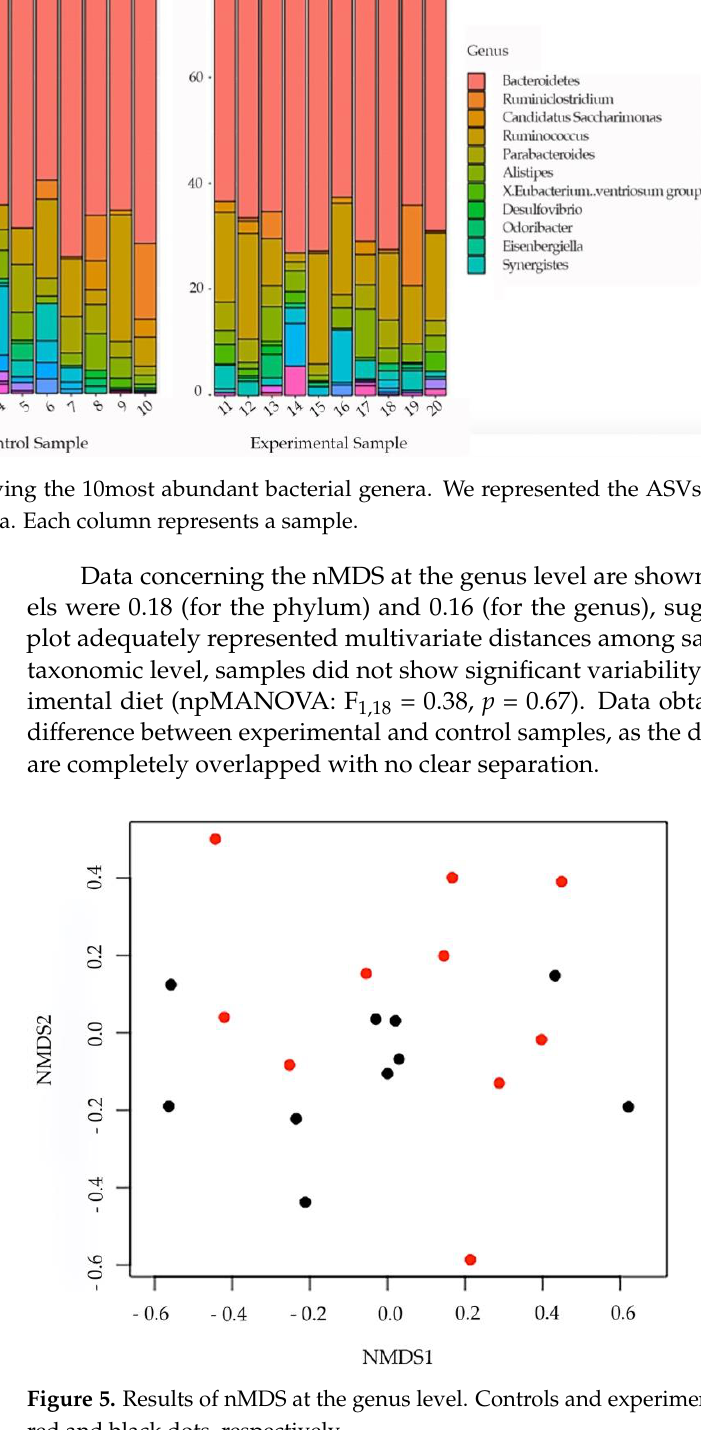
Figure 5. Results of nMDS at the genus level. Controls and experimental samples are represented by red and black dots,